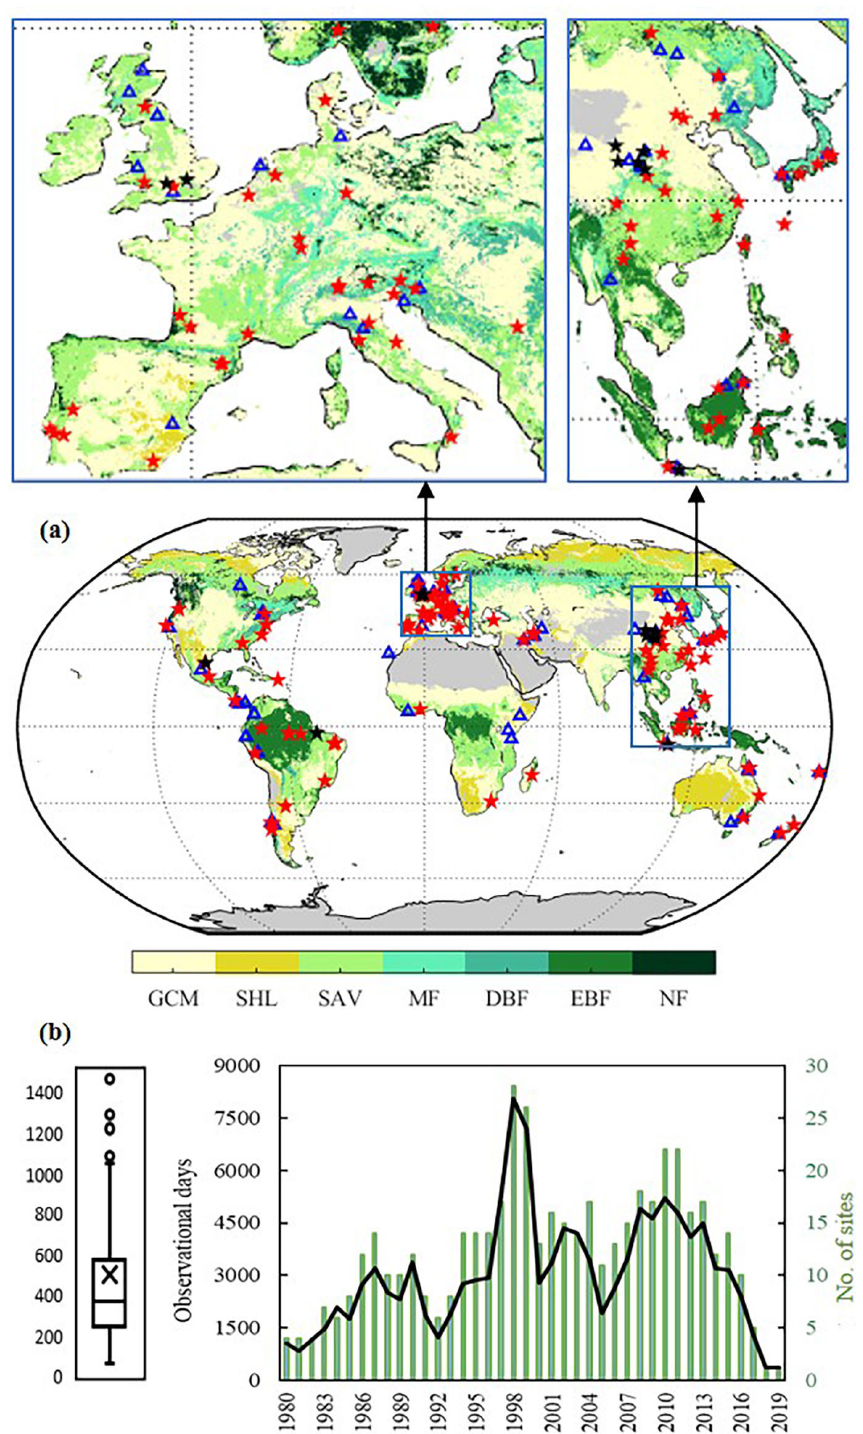
Figure 1. (a) Spatial distribution of experimental sites and vegetation cover types. Red and black stars represent tall-vegetation and short- vegetation sites retained for validation (respectively), while blue triangles are discarded sites. Vegetation cover is based on the IGBP clas- sification of MCD12C1 corresponding to 2001, including evergreen needleleaf forests and deciduous needleleaf forests (NF), evergreen broadleaf forests (EBF), deciduous broadleaf forests (DBF), mixed forests (MF), woody savannas and savannas (SAV), closed shrublands and open shrublands (SHL), and grasslands, croplands and cropland/natural vegetation mosaics (GCM). (b) Observational days of field experiments (left) and the number of days and sites each year